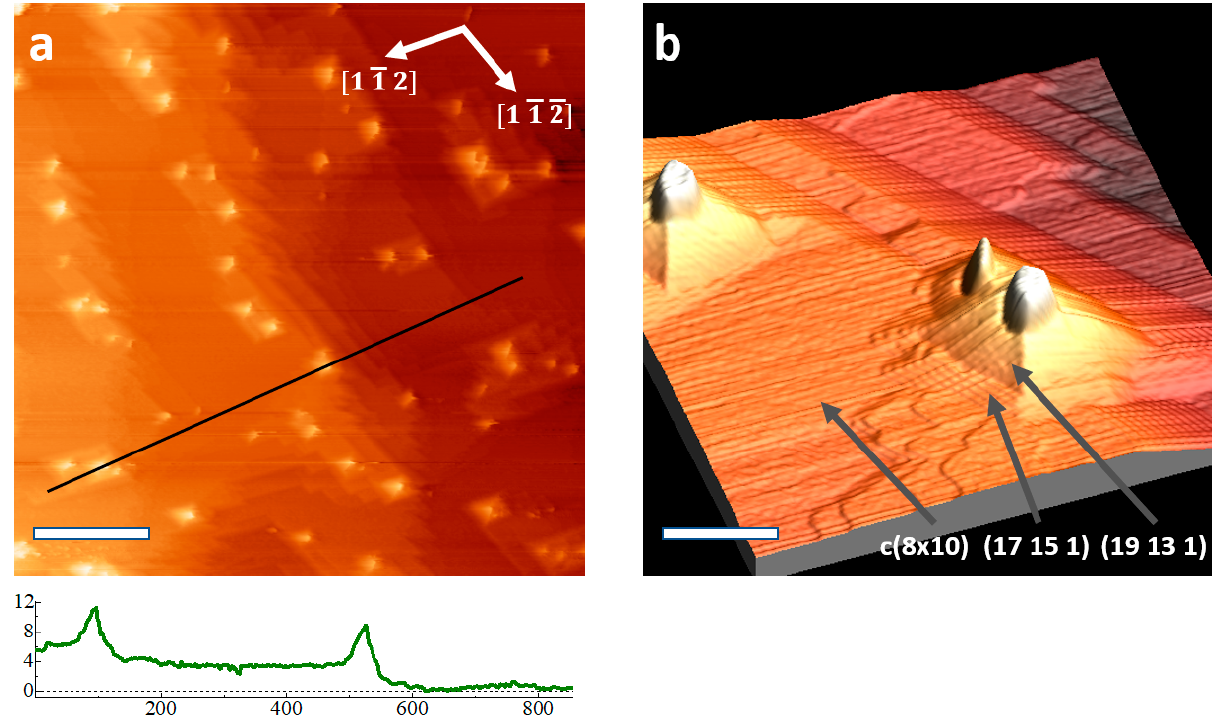
Figure 1. Scanning tunneling microscopy (STM) image of a Ge (110) sample that was coated with 10 MLs of Ag, followed by 10 cleaning cycles performed using 250 eV Ar + ions. Imaging parameters 0.5 nA, 2 V tip bias. ( a ) Topographical image with profile (units in nm) taken along line shown below; ( b ) 3D image (magnified near center of ( a )). Fluence: 4.8 × 10 17 cm − 2 . Scale bars: ( a ) 200 nm, ( b ) 40 nm.